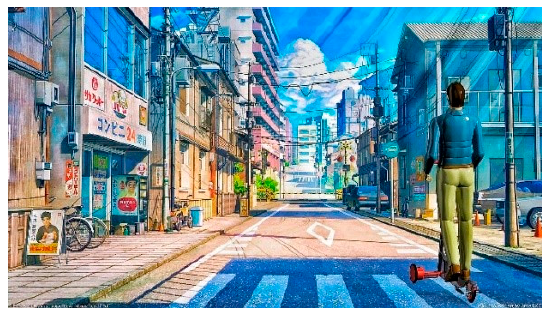
Figure 12. Final rendering.